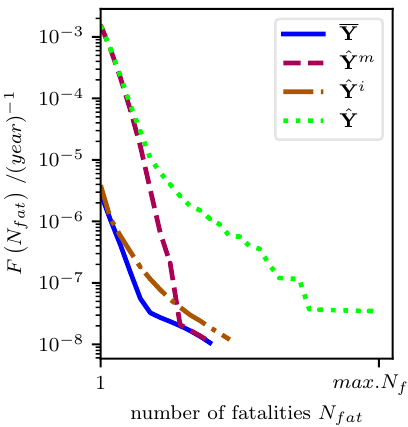
Figure 8. Effects of the metamodel uncertainty and inherent uncertainty on the frequency F of scenarios with N fat fatalities; to be noted: the societal risk curve accounts for N fat ≥ 1, which hides all random scenarios leading to zero fatalities; the maximum number of fatalities is in the range of max . N fat ≈ 10 2 , where the exact number is not relevant for the evaluation of the